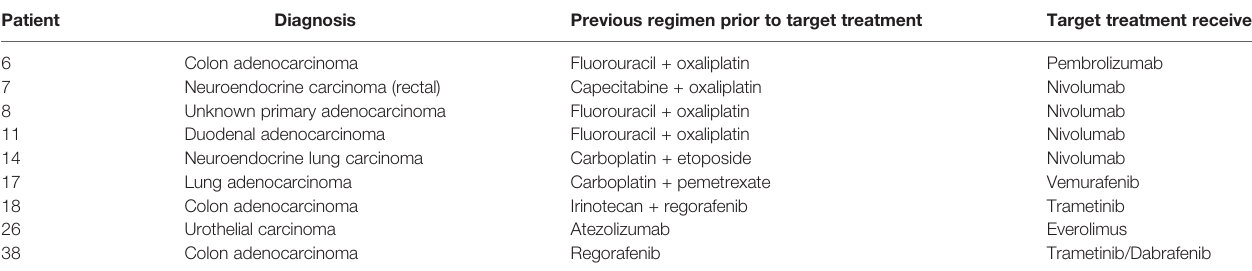
TABLE 5 | Treatment regimen received by nine patients with ratio of PFS ≥ 1.3.